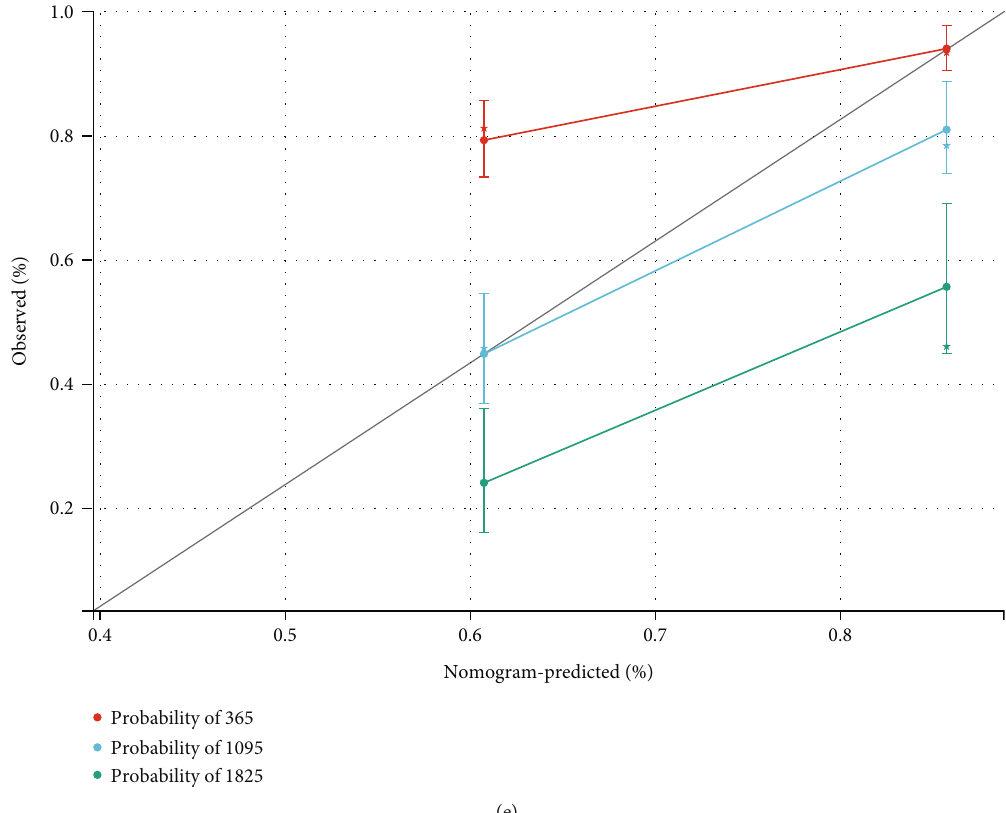
Figure 4: Evaluation of the sensitivity and independency of the cuproptosis-relevant lncRNA signature in prognosis prediction and generation of a nomogram for LUAD. (a) K-M curves of OS between low- and high-risk subsets in diverse subgroups strati fi ed by known clinicopathological parameters. (b, c) Forest diagrams depicting uni- and multivariate-cox regression results of the relationships of the cuproptosis-relevant lncRNA signature and clinicopathological parameters with OS outcomes. (d) Generation of a nomogram scoring system incorporating the cuproptosis-relevant lncRNA signature together with clinicopathological parameters (histological stage, TNM). Each variable corresponds to a point, and total point refers to the total score obtained by adding up the corresponding points of all variables. (e) Calibration curves illustrating the nomogram scoring system-estimated and clinically observed 1-, 3-, and 5-year OS